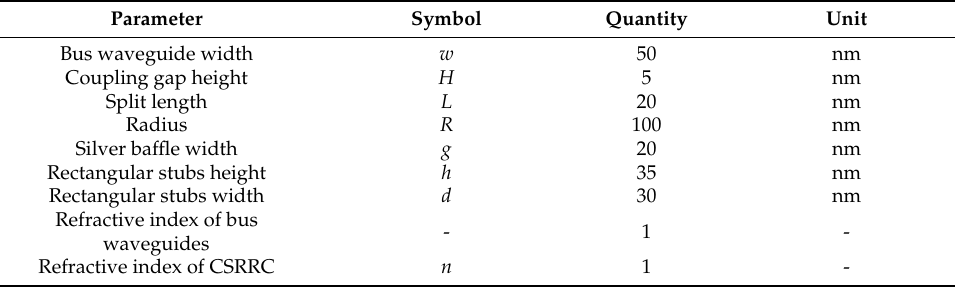
Table 1. Summary of calculated structural